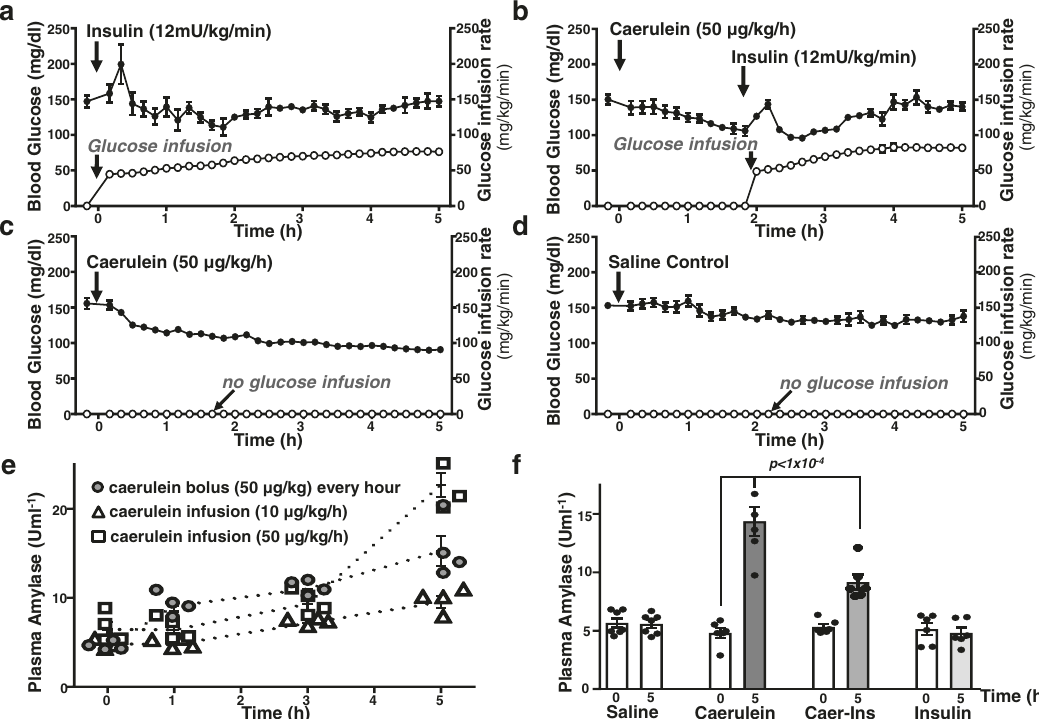
Fig. 9 Caerulein infusion-induced increase in plasma amylase is reduced by insulin infusion with tight glycaemic control using the hyperinsulinaemic euglycaemic clamp. C57BL/6 mice were catheterized via the carotid artery and jugular vein under recover anaesthesia to allow the continuous infusion of caerulein (to induce acute pancreatic injury), insulin (12 mU/kg/min) and glucose (variable rate) to maintain euglycaemia. Caerulein-induced acute pancreatic injury was experimentally induced by continuous infusion of caerulein (50 μ g/kg/h) over 5 h and plasma amylase was assessed as an early and immediate readout of pancreatic injury during the course of the experiment ( e ) and at the end ( f ). Mice were separated into 4 groups of 6 mice receiving insulin alone ( a ), caerulein and insulin ( b , insulin added 2 h into the caerulein infusion), caerulein alone ( c ) or saline control ( d ). For clarity, data are presented as mean ± SEM assessed every 10 min during the entire 5 h. The same data are presented as dot plots showing the full data distribution with lines connecting the mean in Fig. S10. The effect of different caerulein administration regimes were compared on plasma amylase at 0, 1 h, 3 h and 5 h (mean plasma amylase± SEM from groups of 4 mice, e ) including; bolus caerulein injection (via IV line) every hour (open square), low dose continuous caerulein infusion (10 μ g/kg/h) and high dose continuous caerulein infusion (50 μ g/kg/h). This higher dose continuous caerulein infusion (50 μ g/kg/h) induced the maximum increase in plasma amylase at 5 h and was therefore used in combination with the hyperinsulinaemic euglycaemic clamp ( b ). Mean plasma amylase (±SEM) from 4 groups of 6 mice measured at 0 and 5 h in saline control, caerulein alone, caerulein with insulin infusion and insulin infusion alone ( f ). Signi fi cance (exact p values as indicated) was determined by one-way ANOVA with Sidak ’ s multiple